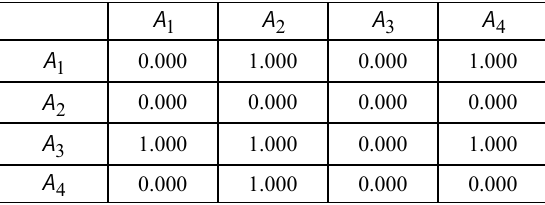
Table 12. Preference degree with respect to criterion 2 C